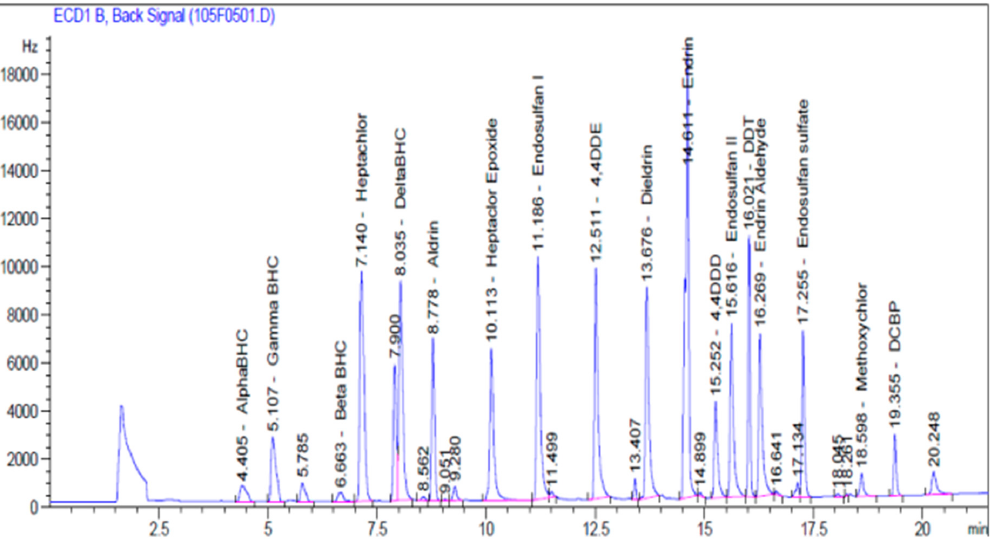
Figure 2. Typical chromatogram of the OCP standard.